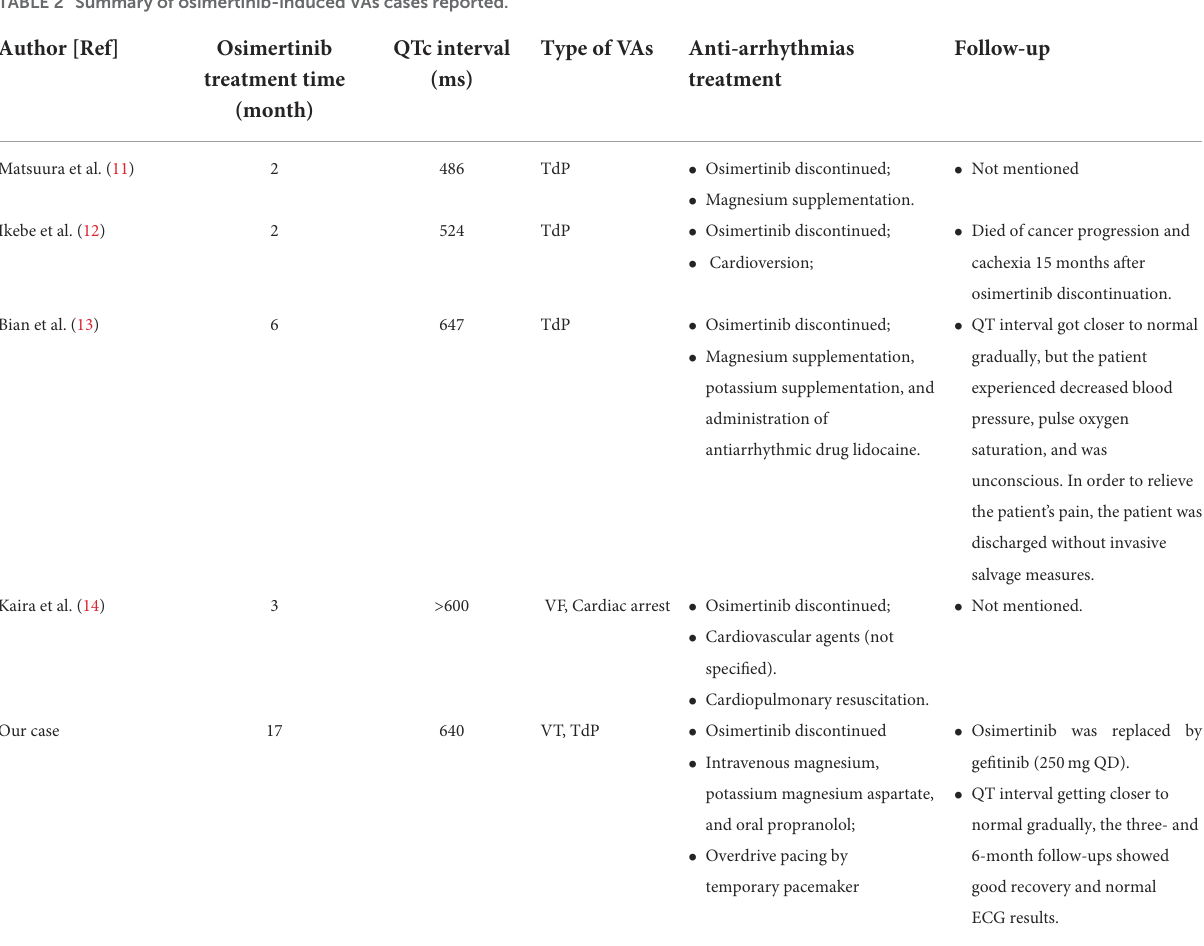
TABLE 2 Summary of osimertinib-induced VAs cases